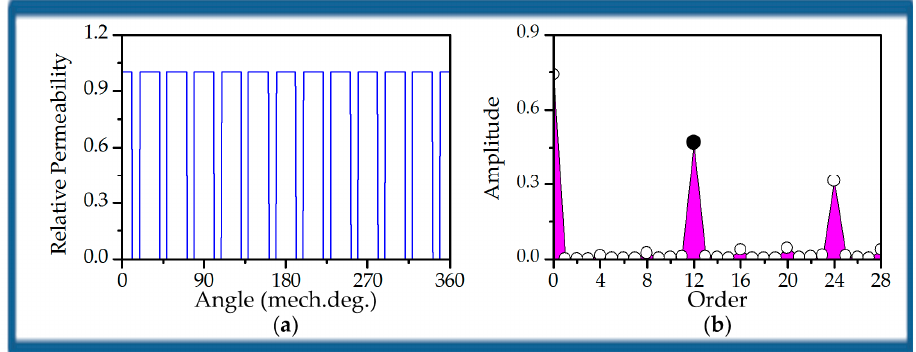
Figure 10. Air-gap relative permeability due to stator iron teeth: ( a ) Waveforms of relative permeability; and, ( b ) Corresponding harmonic spectrum.